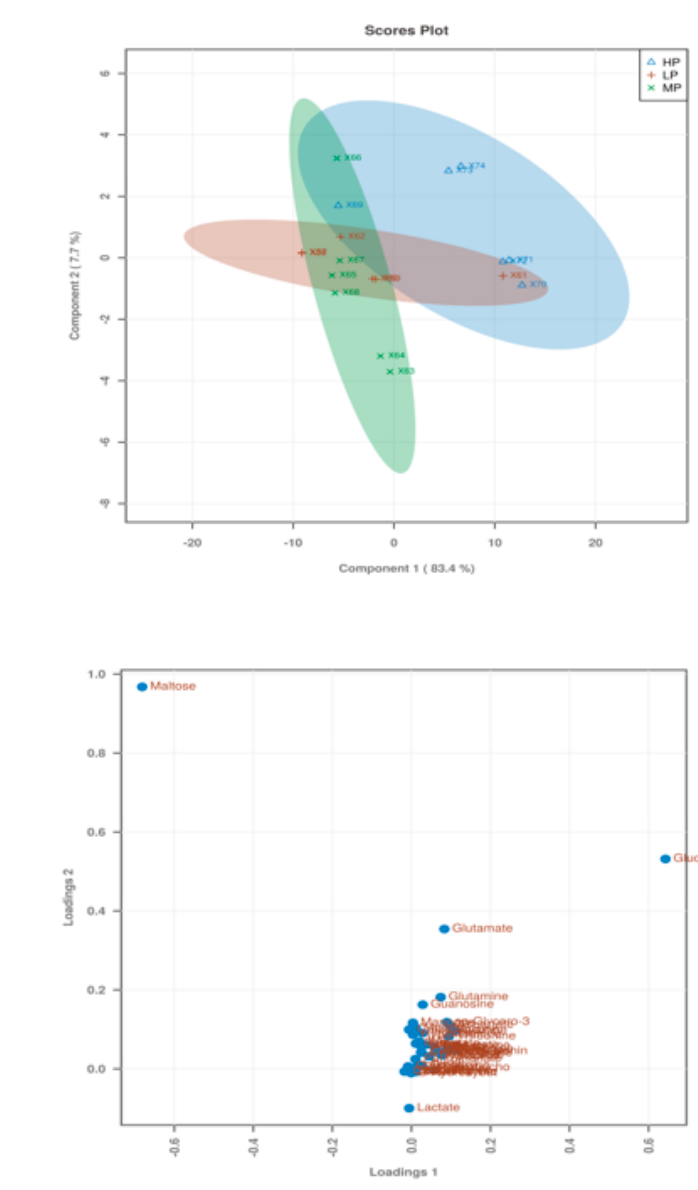
Figure 6. PLS-DA score plots and loading plots of liver data. ( a ) PLS-DA score plots; ( b ) PLS-DA Figure 6. PLS ‐ DA score plots and loading plots of liver data. ( a ) PLS ‐ DA score plots; ( b ) PLS ‐ DA loading loading plots.